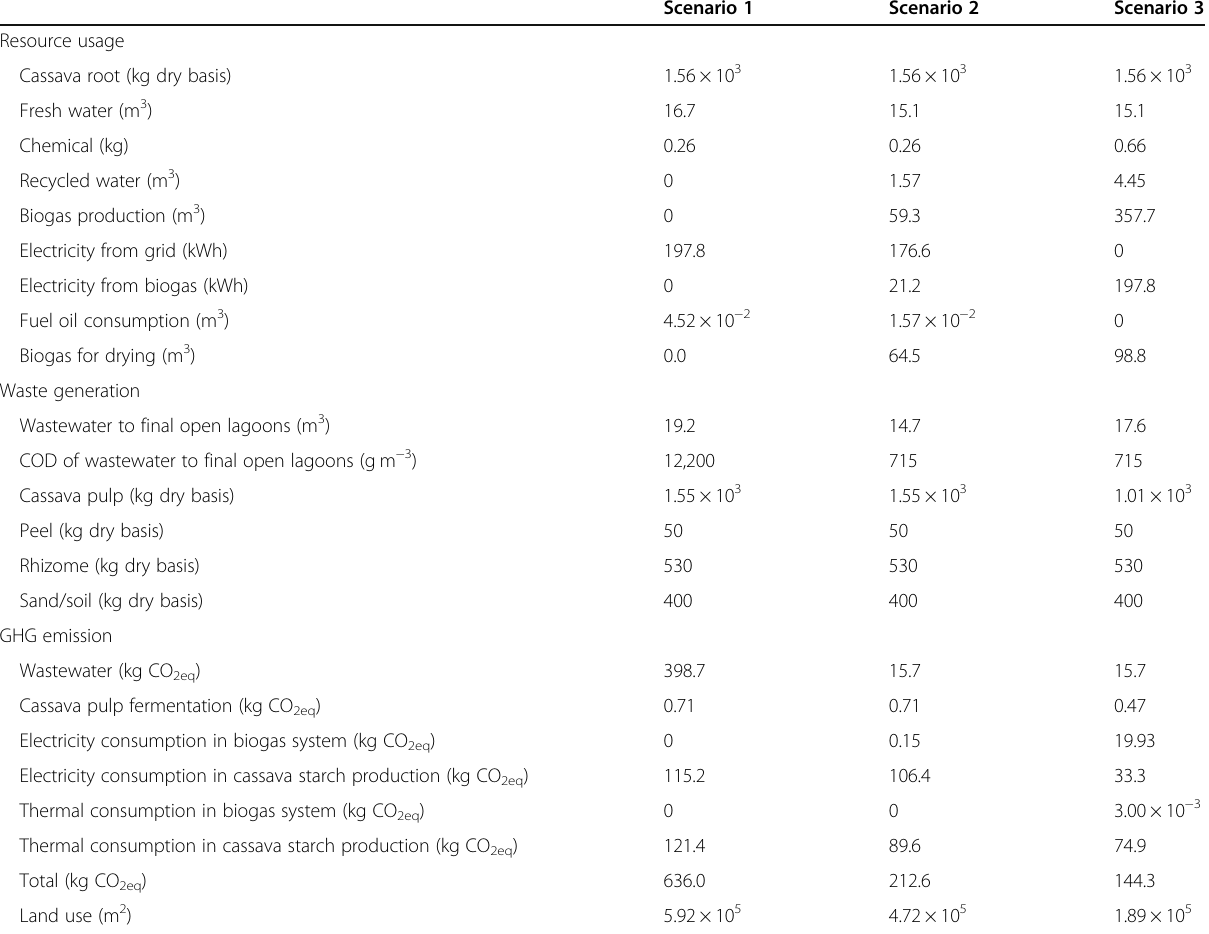
Table 1 The resource usage, waste generation, GHG emission, and land use of the Thai CSPP (per 1000 kg of starch). Three scenarios of starch production are (1) a factory without integrated biogas system, (2) a factory with integrated biogas installation using wastewater as a raw material, and (3) a factory with biogas system using both wastewater and cassava pulp as raw